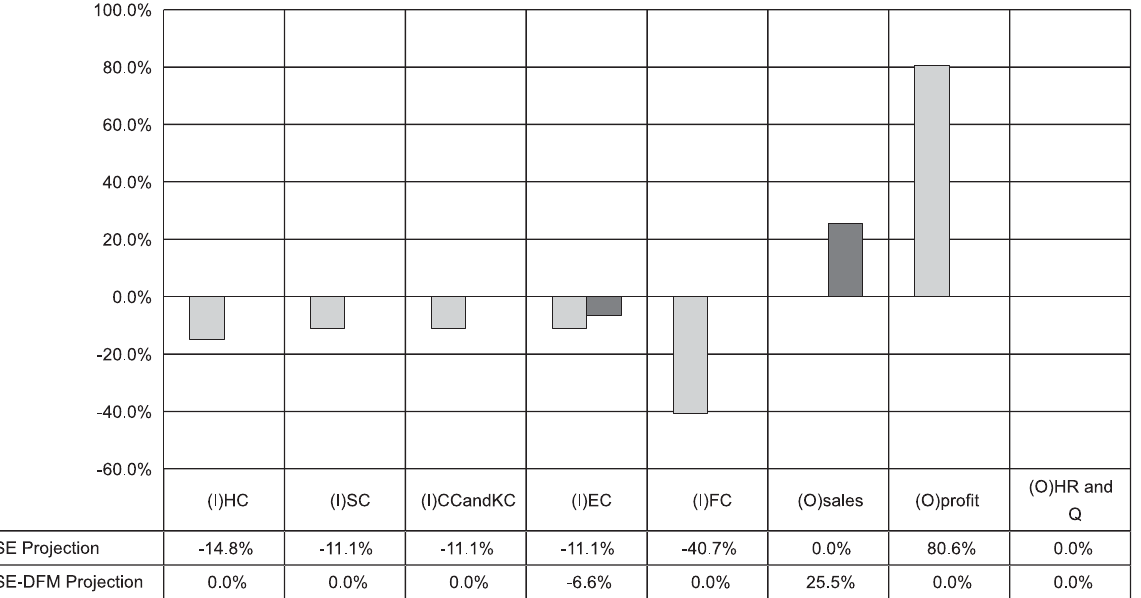
Fig. 3. Projection results of Firm 18, based on SE and